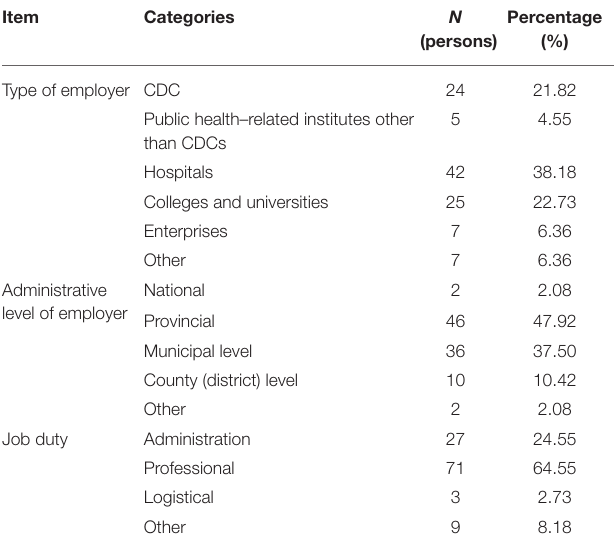
TABLE 2 | Current employment situation of Master’s graduates in